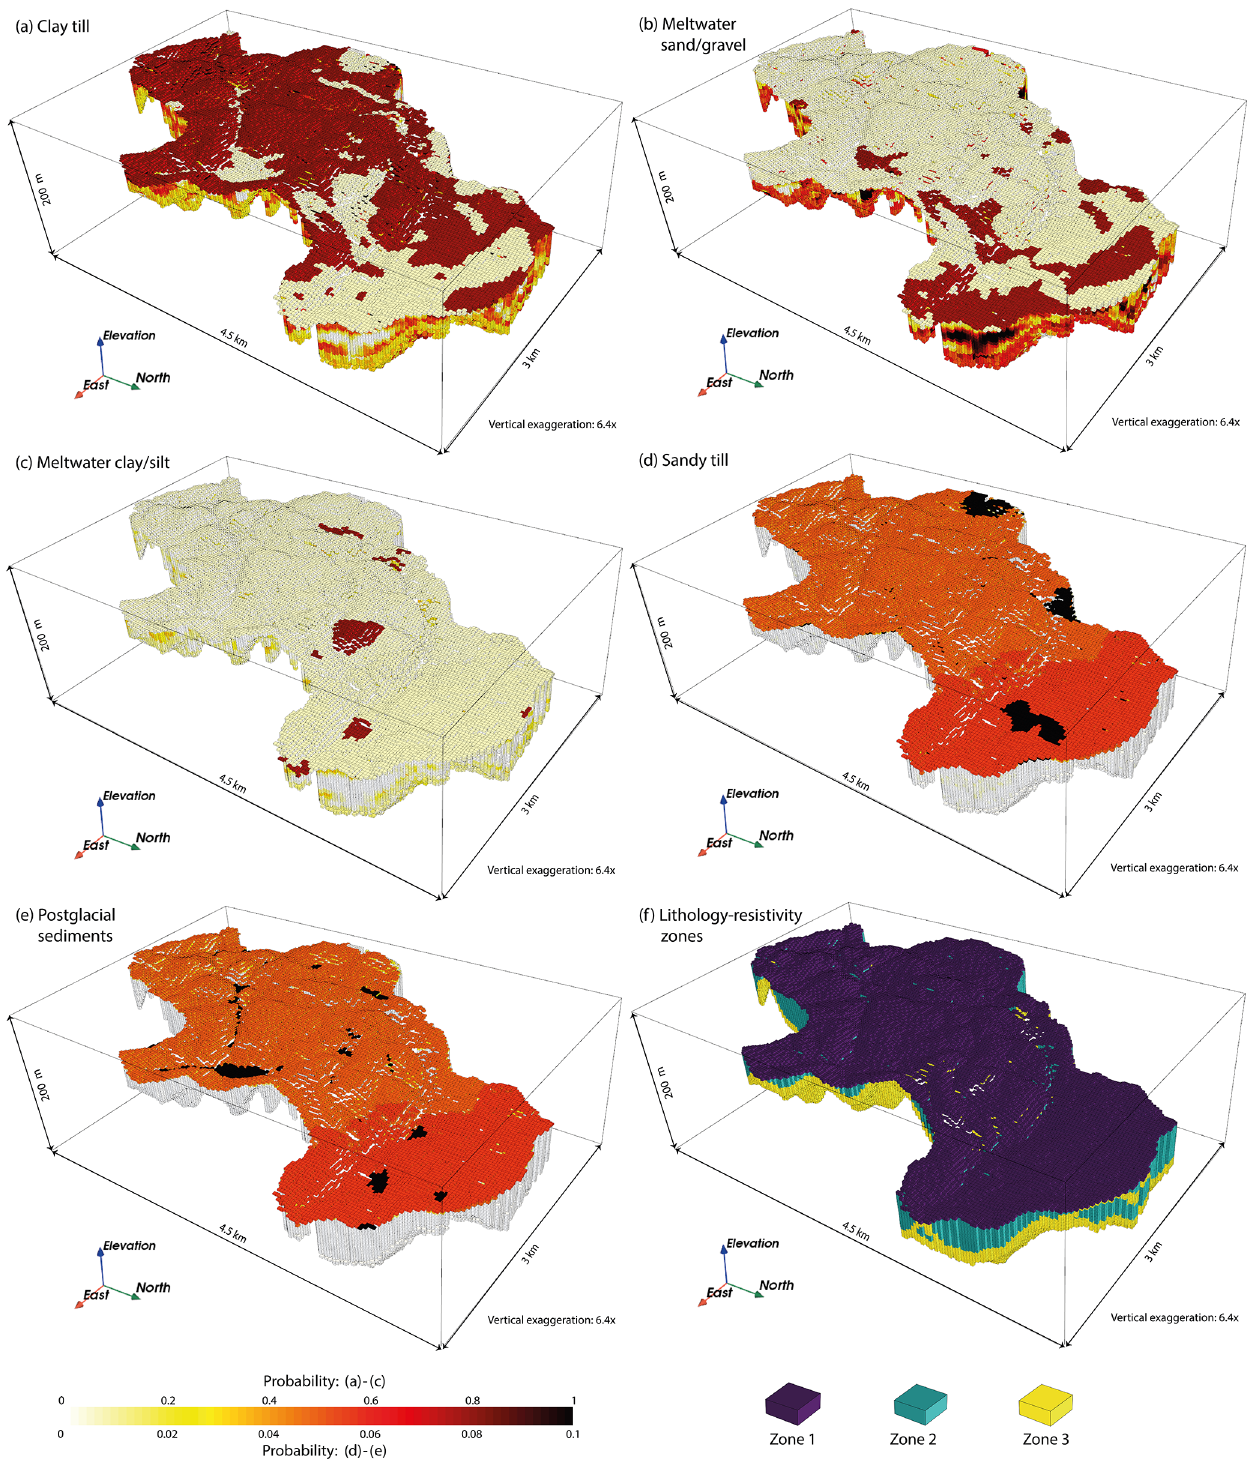
Figure 9. (a–e) Soft data probabilities of geology for the buried valley element. Soft data probabilities calculated from the surface geology and tTEM data available. Note the smaller range in the color scale of the sandy till (d) and postglacial sediments (e) .